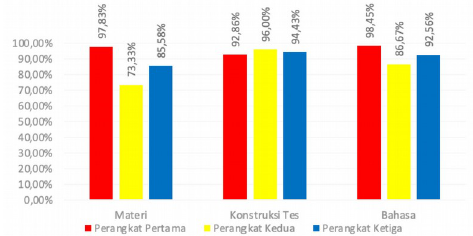
Figure 9. Expert Theoretical Validation